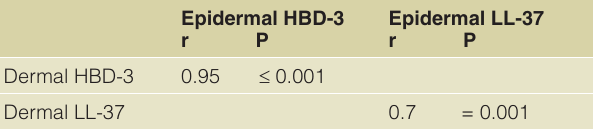
Table 3. Correlation between immunostaining scores of epidermal and dermal HBD-3 and